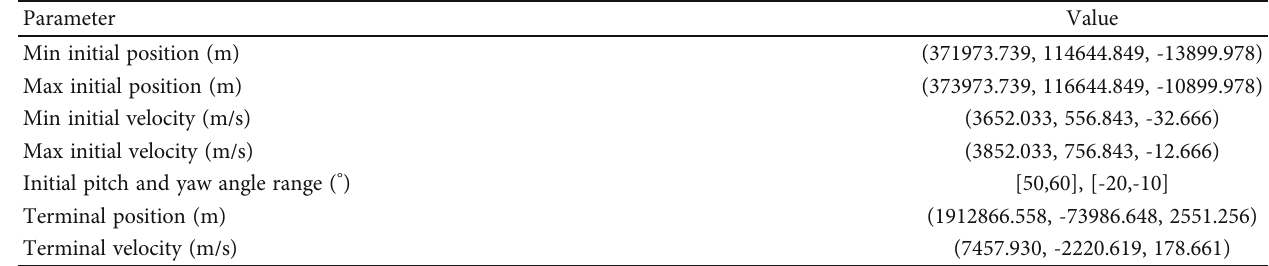
Table 1: Parameters of boundary conditions.